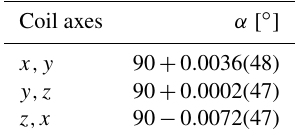
Table 3. Angle α between two axes of the 3D coil system with uncertainty on a confidence level of 95% (last two